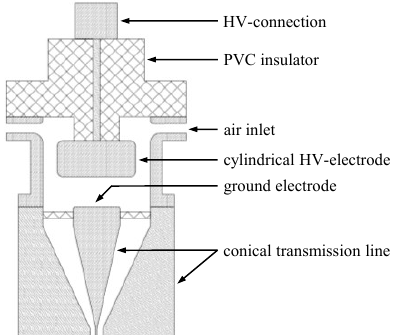
Fig. 2. Sectional view of the measuring cell optimized from a high voltage and high frequency point of view.